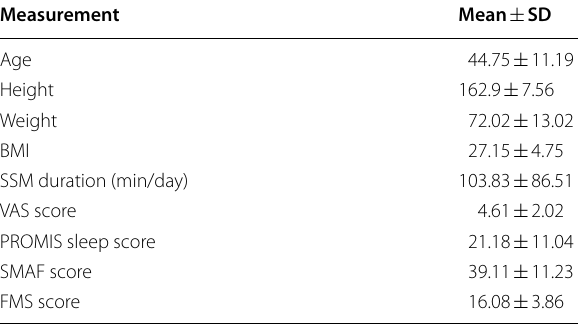
Table 2 Analysis of patient measurements